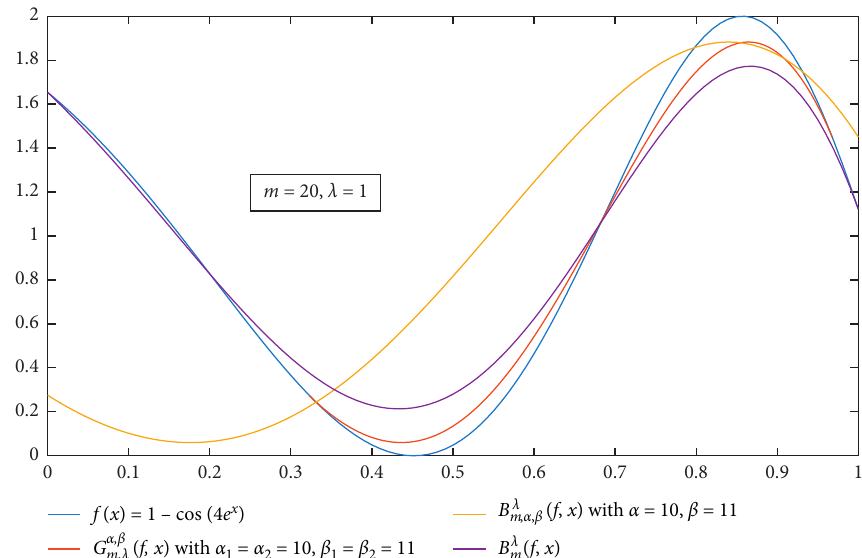
Figure 5: Convergences of G 10 , 11